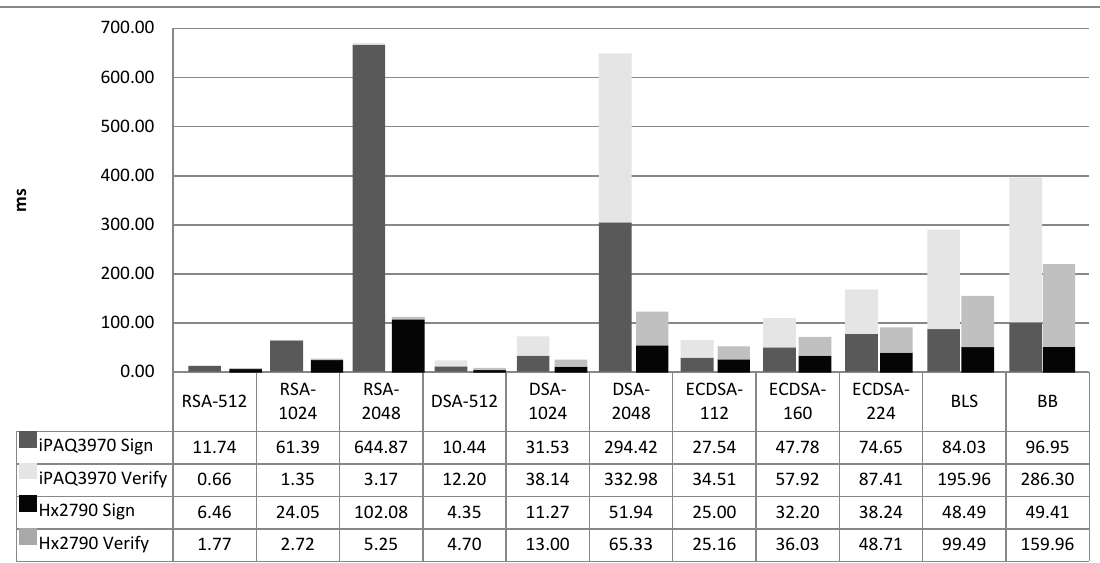
Figure 5. Temporal costs of digital signature